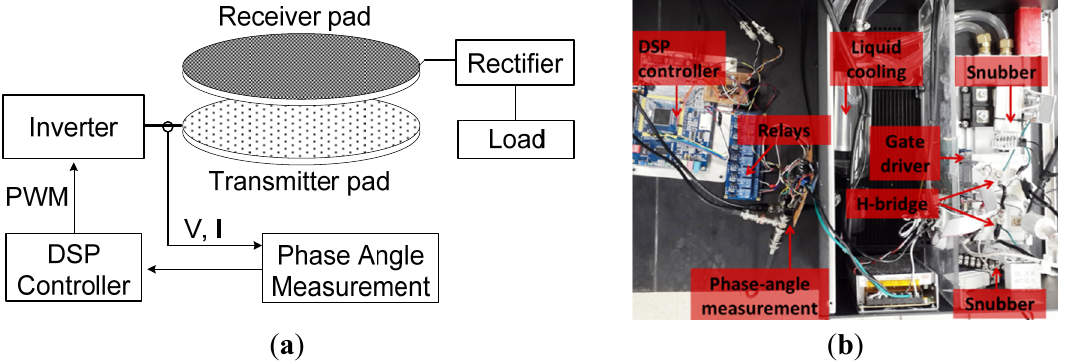
Figure 1. ( a ) Overview of the WPT system; ( b ) Inverter and control